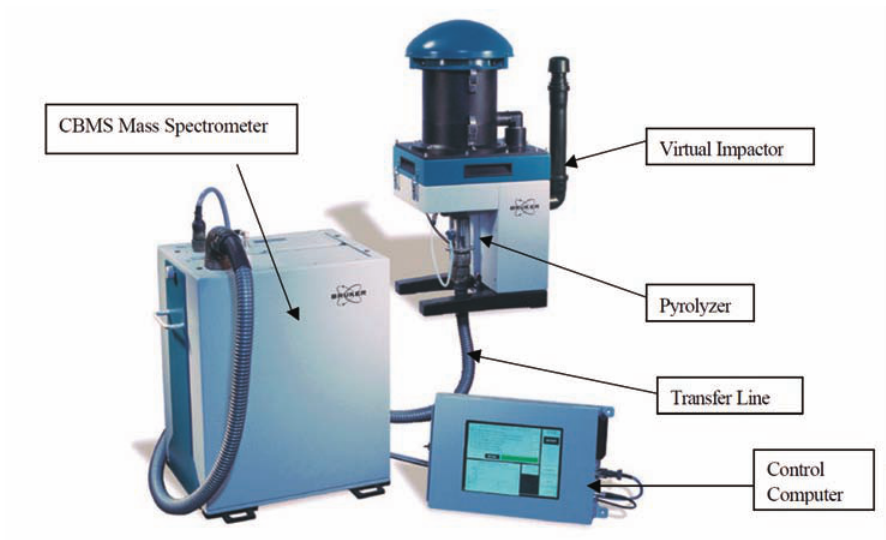
Fig. 4 A portable mass spectrometer coupled to a virtual impactor for concentrating biological aerosols particles (www. armedforces-int.com/article/bruker-daltonics-inc-nbc-instruments.html accessed 9 March